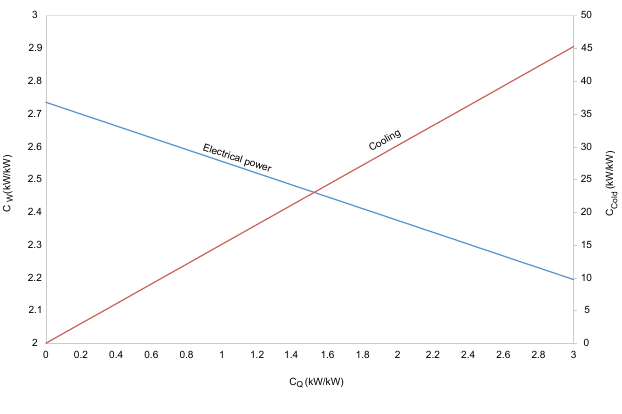
Figure 6. Variation of the unit exergy cost of electricity and refrigeration as a function of by-product exhausted gas